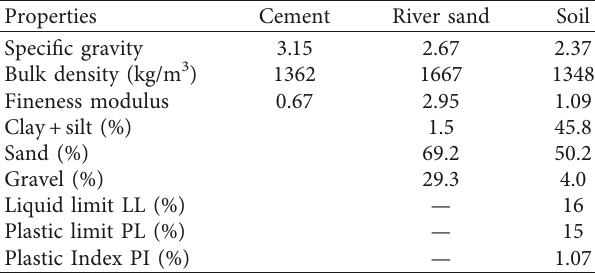
Table 2: Physical properties of cement, sand, and